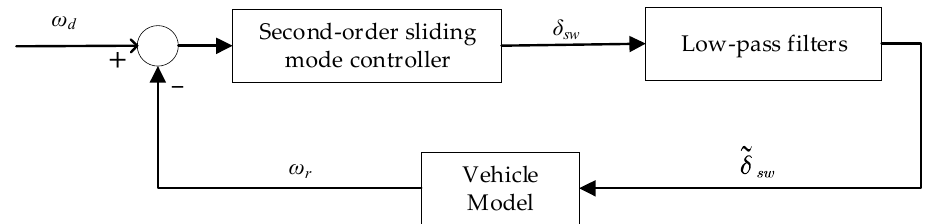
Figure 3. Low-pass filter-based second-order sliding mode controller architecture.